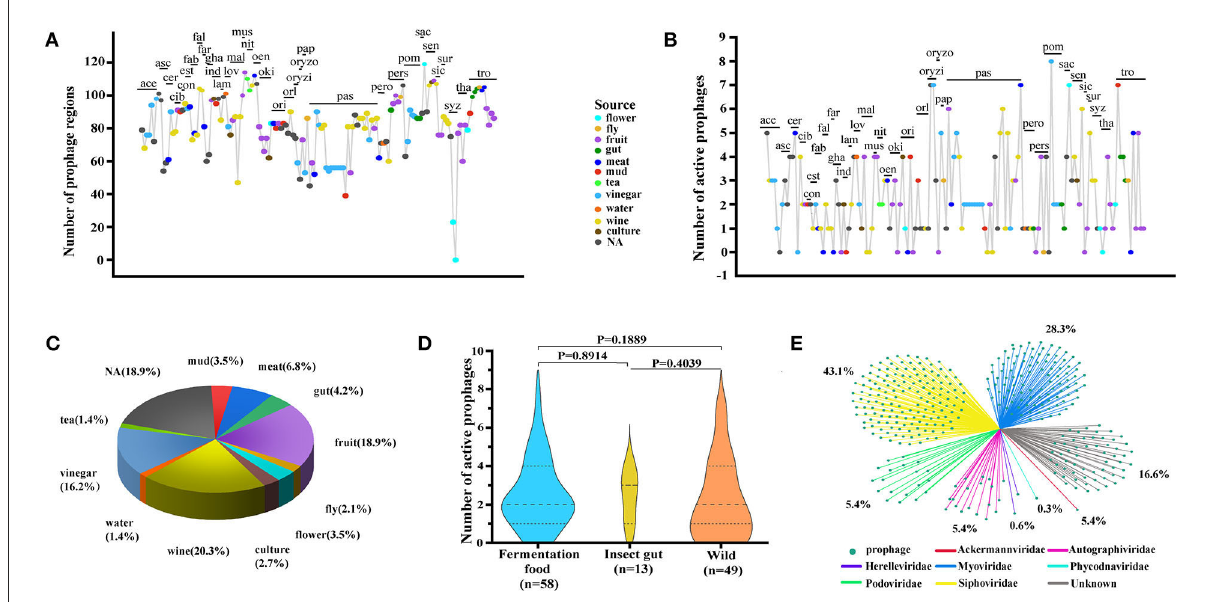
FIGURE1 Depiction of prophages for 34 Acetobacter species. (A) All prophage fragments predicted in Acetobacter . (B) Active prophages predicted in Acetobacter . The above serial numbers are the classification of Acetobacter species (see Supplementary Table S1): A. aceti (ace); A. ascendens (asc); A. cerevisiae (cer); A. cibinongensis (cib); A. conturbans (con); A. estunensis (est); A. fabarum (fab); A. fallax (fal); A. farinalis (far); A. ghanensis (gha); A. indonesiensis (ind); A. lambici (lam); A. lovaniensis (lov); A. malorum (mal); A. musti (mus); A. nitrogenifigens (nit); A. oeni (oen); A. okinawensis (oki); A. orientalis (ori); A. orleanensis (orl); A. oryzifermentans (oryzi); A. oryzoeni (oryzo); A. papaya (pap); A. pasteurianus (pas); A. peroxydans (pero); A. persici (pers); A. pomorum (pom); A. sacchari (sac); A. senegalensis (sen); A. sicerae (sic); A. suratthaniensis (sur); A. syzygii (syz); A. thailandicus (tha); and A. tropicalis (tro). (C) Statistics of the source of Acetobacter isolates. (D) Comparison of predicted active prophages among the fermentation habitat group, the insect gut habitat group, and the variable habitat group. Statistical significance tests were performed using the nonparametric Mann–Whitney U -test, and two-tailed values of p- value were calculated. (E) Statistics of the family of